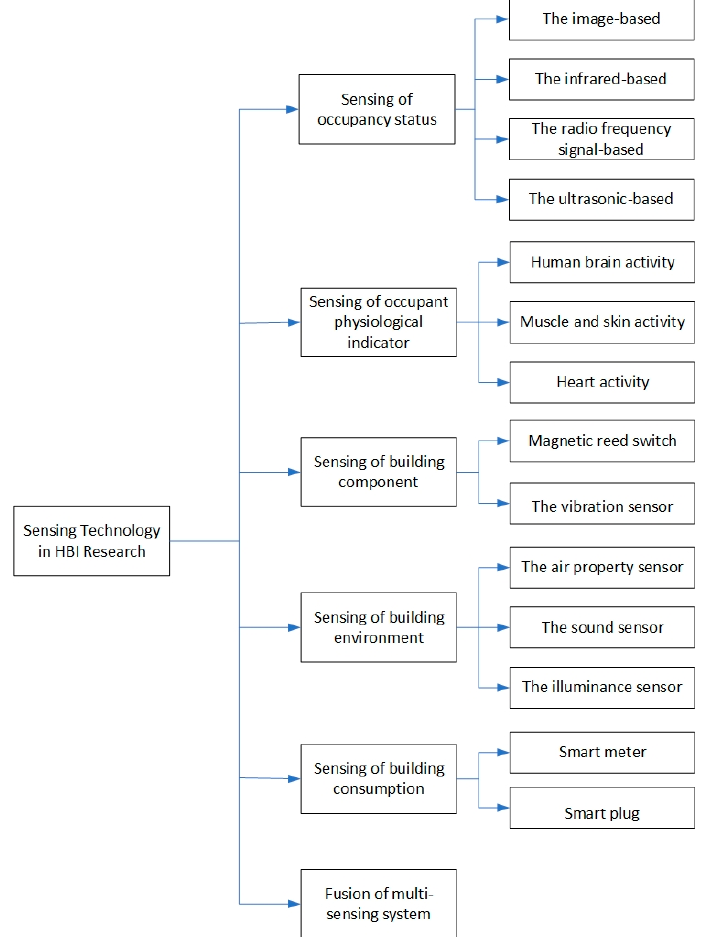
Figure 2. The framework of sensing technology adopted by HBI research.